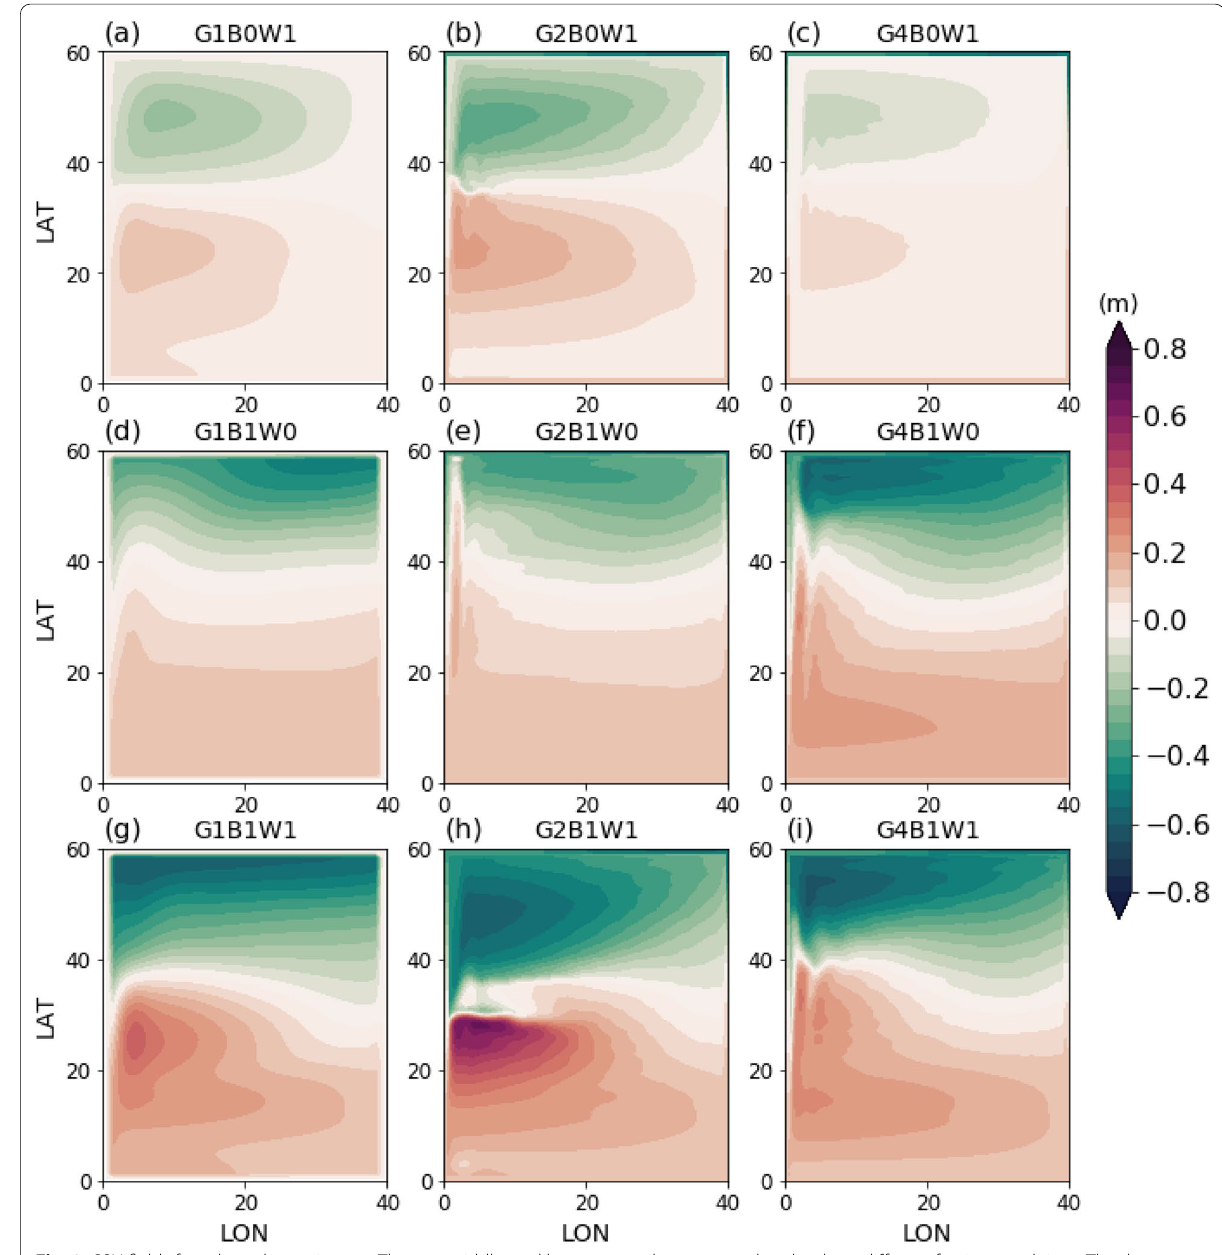
Fig. 2 SSH fields for selected experiments. The top, middle, and bottom panels correspond to the three different forcing conditions. The three columns correspond to the three groups with different combinations of horizontal resolution and vertical